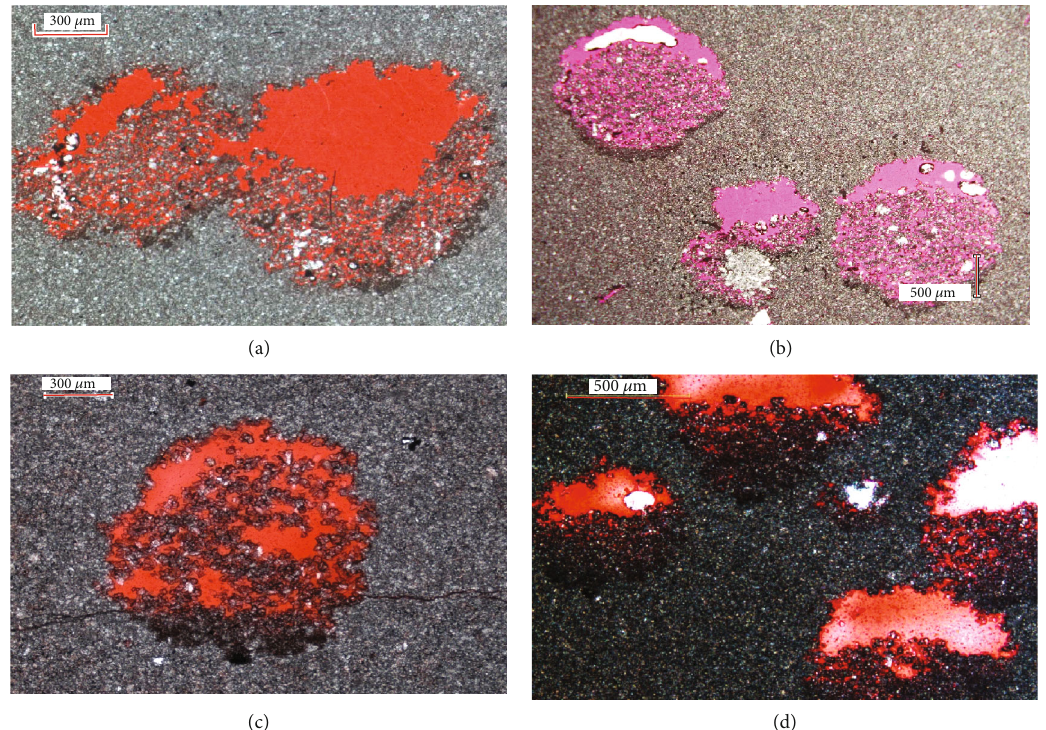
Figure 3: The occurring characteristics of anhydrite dissolution pores in the Ordovician Majiagou Formation in the Jingbian Gas Field (red and pink casting colors represent anhydrite dissolution